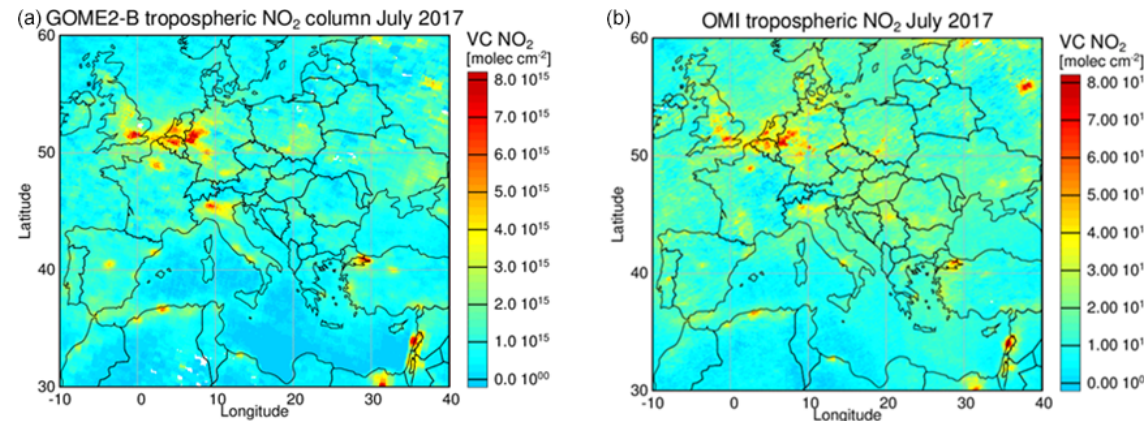
Figure 1. Satellite tropospheric NO 2 columns retrieved from GOME-2B (panel a , overpass at 09:30LT) and OMI (panel b , overpass at 13:45LT) instruments for the IOP period in July 2017. Table 1. (a) Model simulations used for flight planning during EMeRGe in Europe. (b) Satellite observations used during EMeRGe in Europe. LT: local